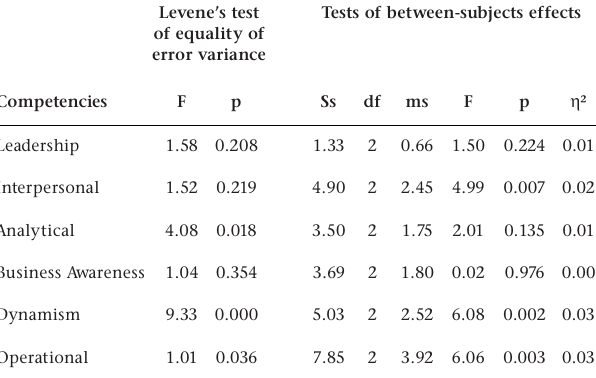
MANOVA SUMMARY TABLE FOR THE PMC SCALES WITH LEVEL OF MANAGEMENT AS INDEPENDENT VARIABLE AND THE SIX SHL